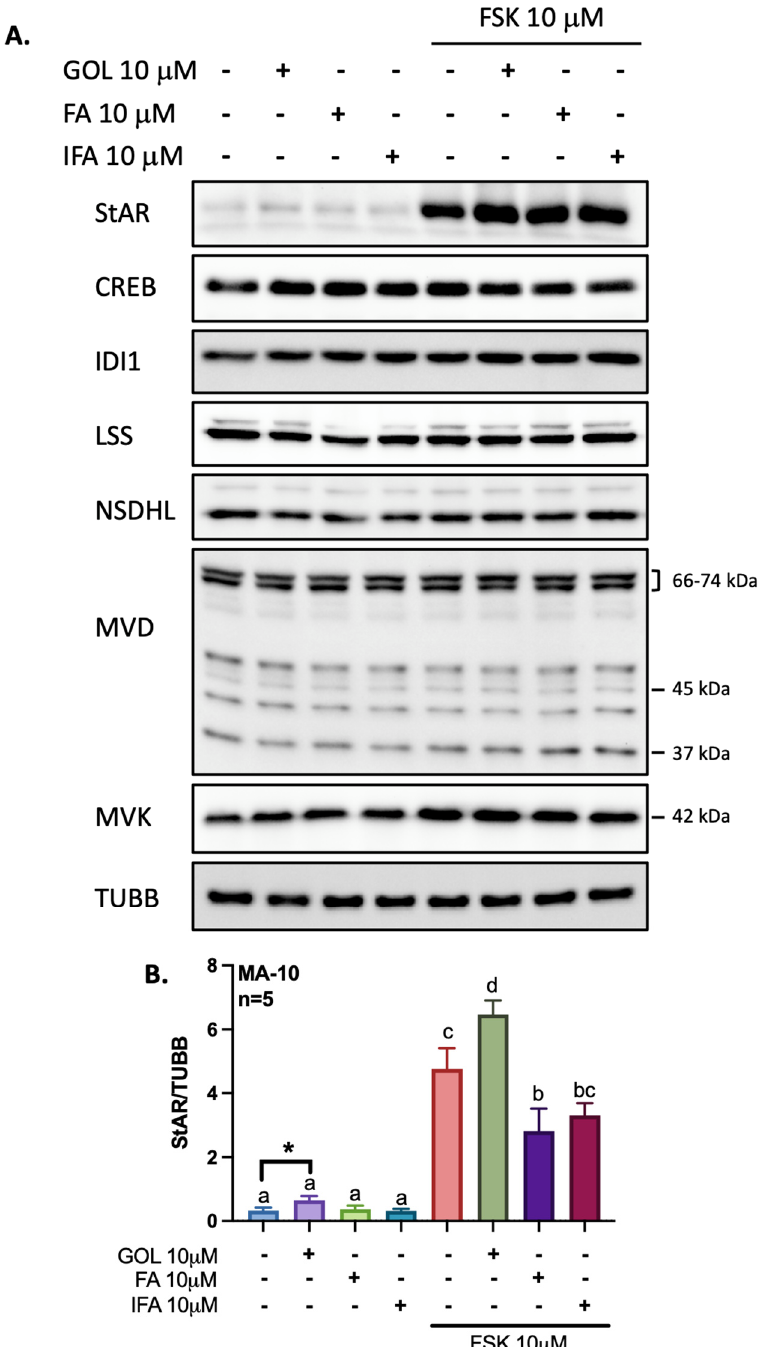
Figure 8. Total protein levels for genes related to regulation of steroidogenesis and cholesterol bio- synthesis. ( A ) Following treatments of MA-10 Leydig cells with 10 μ M gigantol (GOL), ferulic acid biosynthesis. ( A ) Following treatments of MA-10 Leydig cells with 10 µ M gigantol (GOL), ferulic (FA), or isoferulic acid (IFA) in the presence or absence of 10 μ M forskolin (FSK) for 4 h, total pro- acid (FA), or isoferulic acid (IFA) in the presence or absence of 10 µ M forskolin (FSK) for 4 h, total proteins were extracted, followed by quantification using Western blot assays. Results are normalized using Tubulin β (TUBB). ( B ) Densitometry ratios of StAR to TUBB are presented. A two-way ANOVA followed by a Tukey’s multiple comparison test was used to analyze data on densitometries. Different letters indicate significant differences ( p < 0.05). The asterisk (*) indicates a statistically significant difference using a paired student t -test ( p =